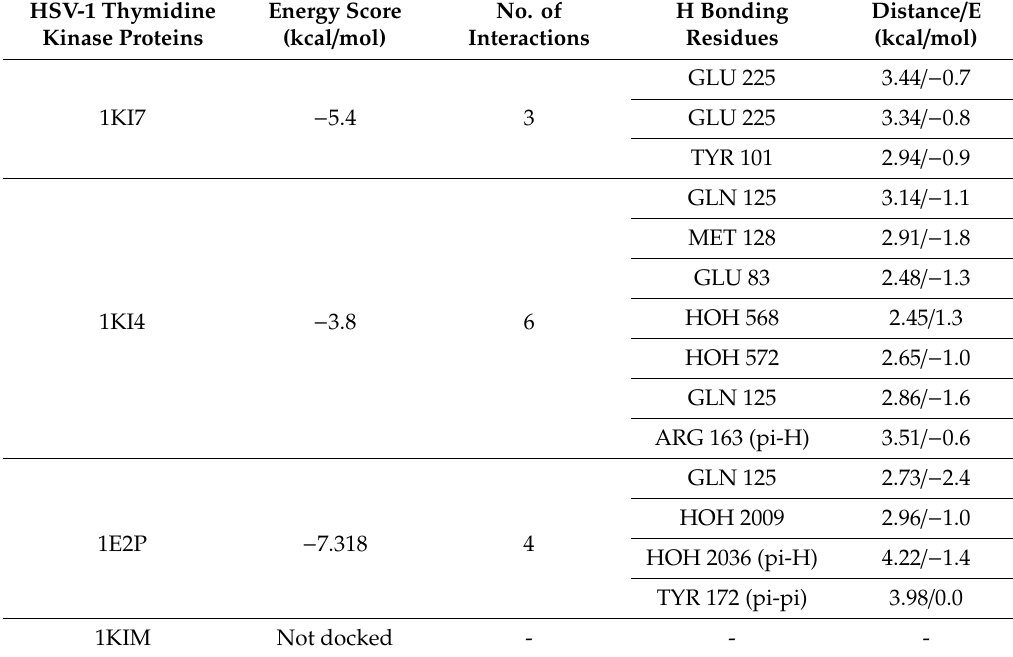
Table 4. Docked conformations of curcumin with HSV-1 thymidine kinase proteins.